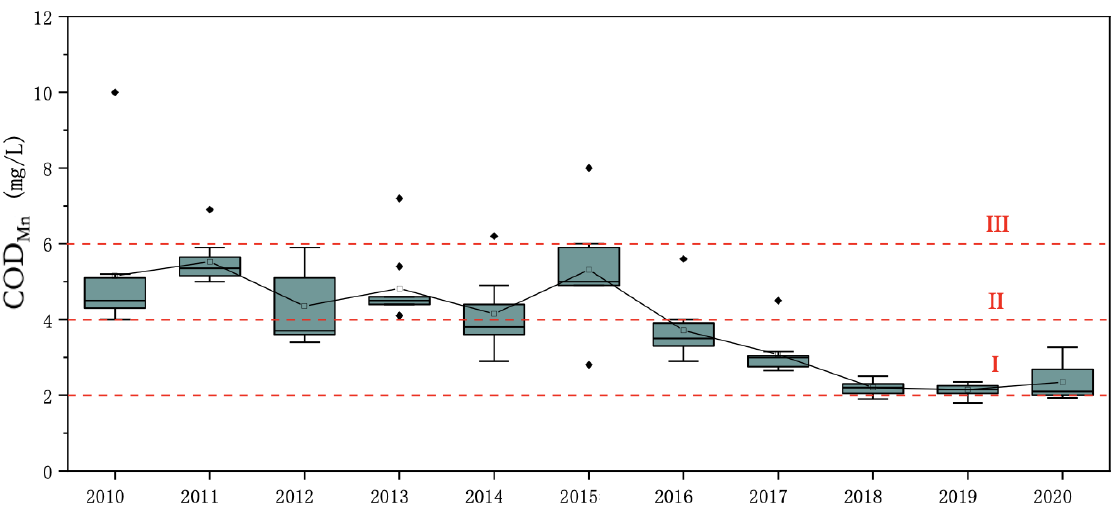
Figure 6. Change trend of the permanganate index in Qinghai Lake from 2010 to 2020.